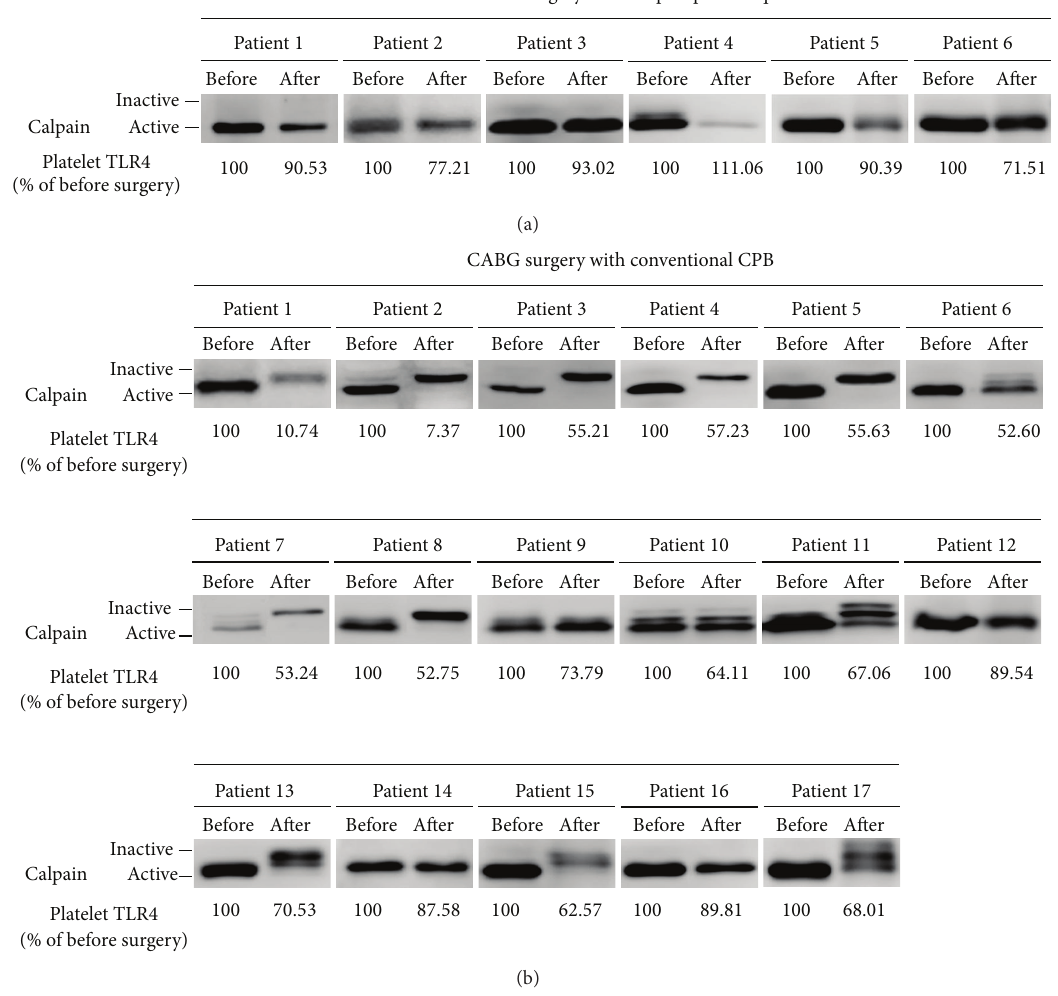
Figure 1: CABG surgery with conventional CPB decreases calpain activity in platelets. (a) Total protein was isolated from washed platelets collected from patients who underwent the off-pump technique. The western blot results demonstrate the calpain activity before and after CABG surgery. (b) Total protein isolated from washed platelets collected from patients who underwent conventional CPB. The western blot results demonstrate the calpain activity before and after CABG